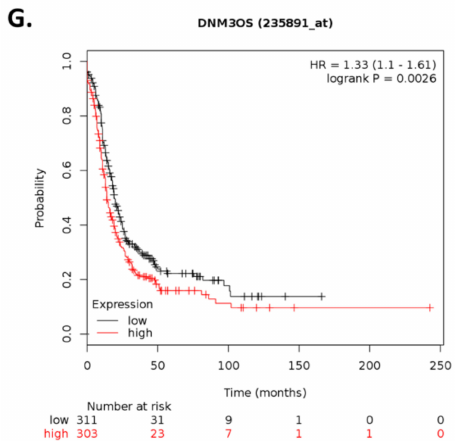
Figure 7. Kaplan–Meier plots for lncRNA expression-based overall survival and progression-free survival analysis. Survival plots of ovarian cancer patients were generated using Kaplan–Meier plotter (KM plotter). Overall survival (OS) of patients with ovarian cancer stratified by expression levels of ( A ) HAR1A is shown based on gene chip data. Progression-free survival (PFS) of patients with ovarian cancer stratified by expression levels of ( B ) MIR7-3HG , ( C ) LINC01134 , ( D ) HAR1A , ( E ) LINC01139 , ( F ) LINC-PINT , and ( G ) DNM3OS are shown based on gene chip data. p -values < 0.05 were considered to be statistically